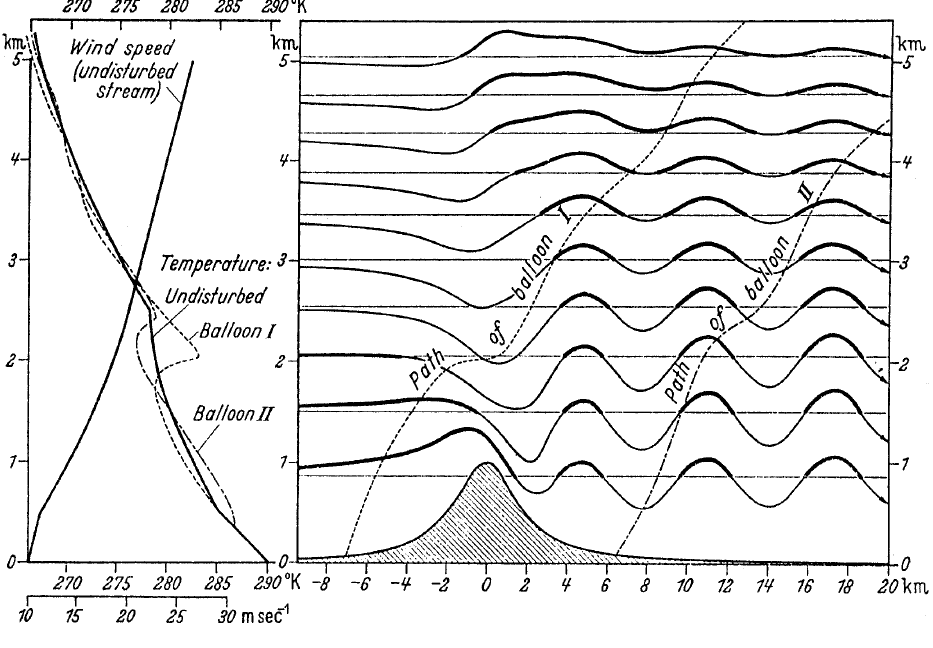
Fig. 1. Air flow over a mountain ridge generating a train of lee waves aloft. The change of phase and amplitude with altitude is caused by a change of the mean wind and temperature, as shown in the left-hand panel (from Scorer, 1997, Copyright